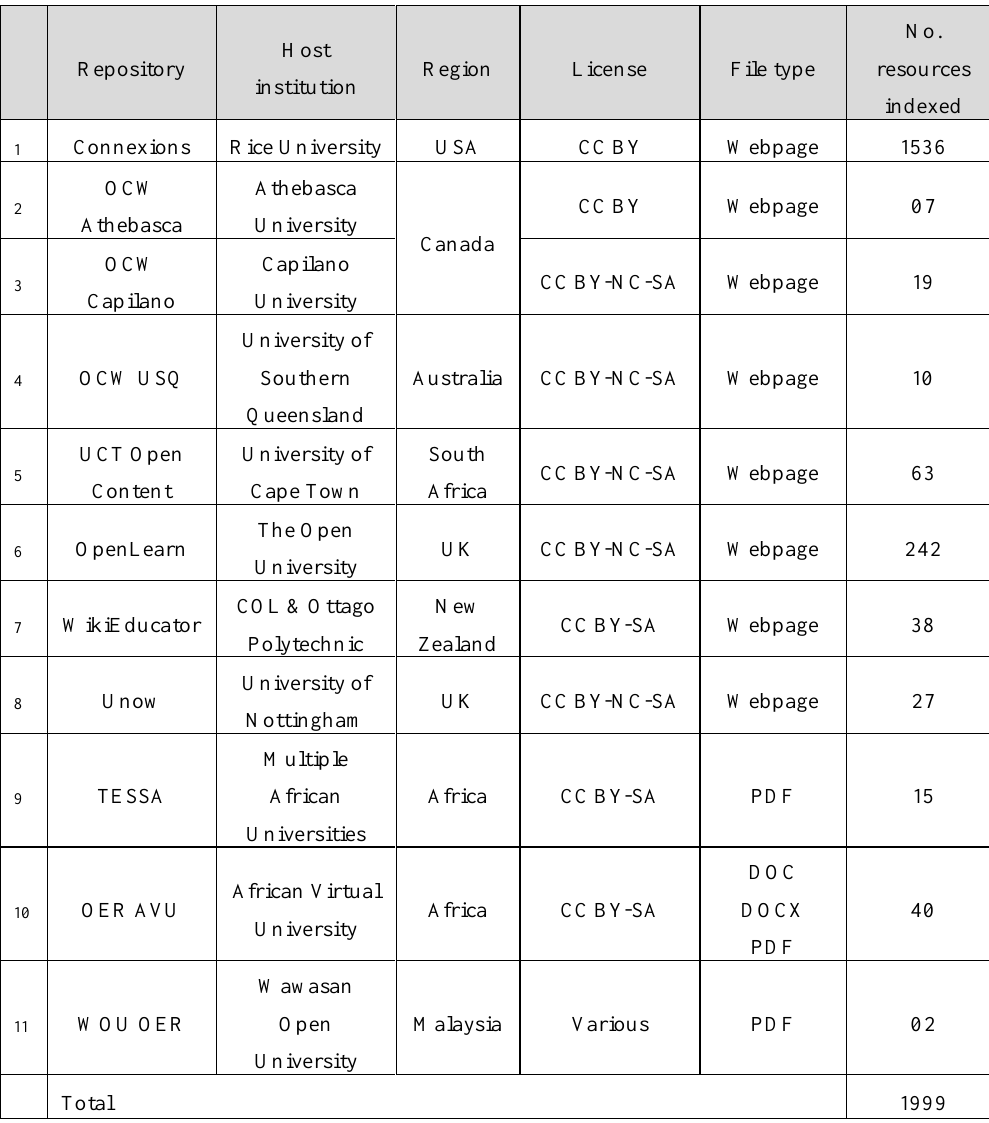
Resources Indexed in the KDM Based on the Initial